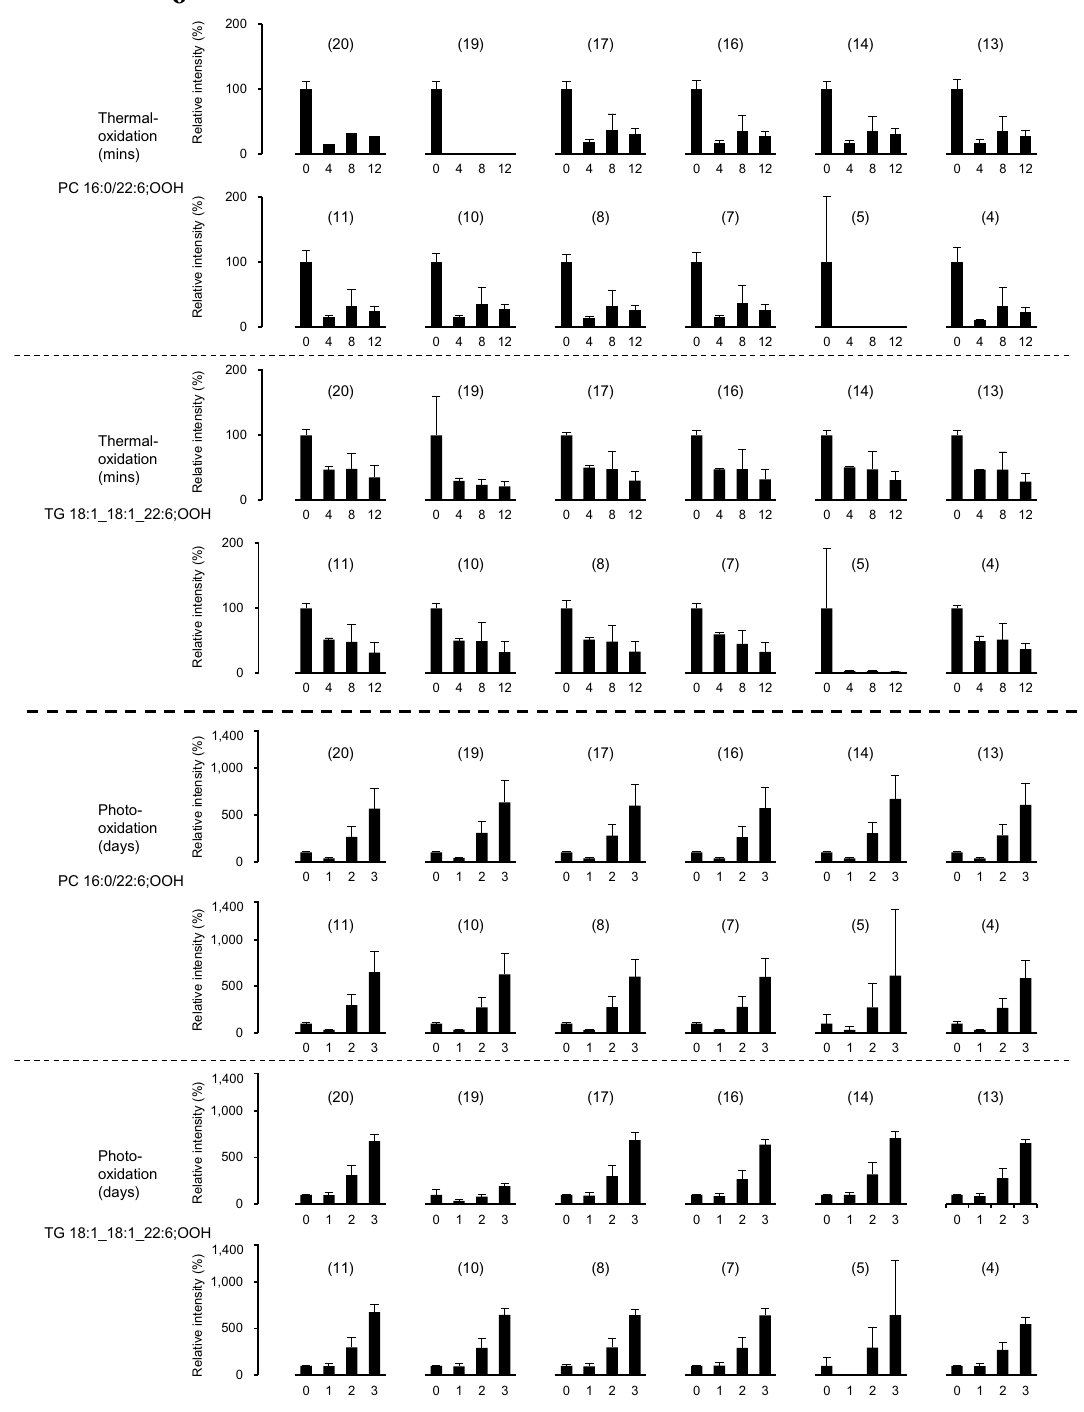
Figure 6. Relative peak area of PC 16:0/22:6;OOH isomers and TG 18:1_18:1_22:6;OOH isomers in mackerel. Values given in parentheses indicate the hydroperoxyl group position. Values are expressed as mean ± SD, n =